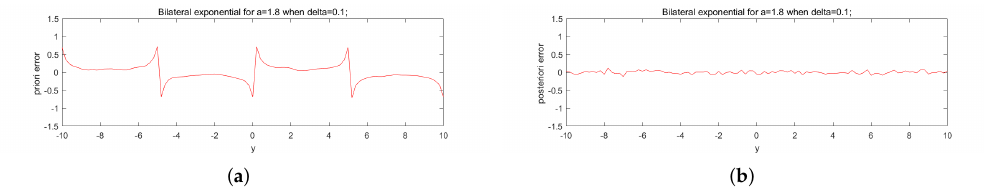
Figure 5. ( a ) A priori error. ( b ) A posteriori error. The errors of a ( x ) when δ = 1 × 10 − 1 , α =